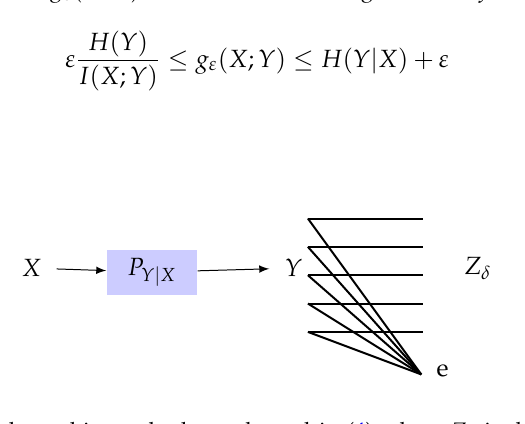
Figure 2. Privacy filter that achieves the lower bound in (4) where Z δ is the output of an erasure privacy filter with erasure probability specified in